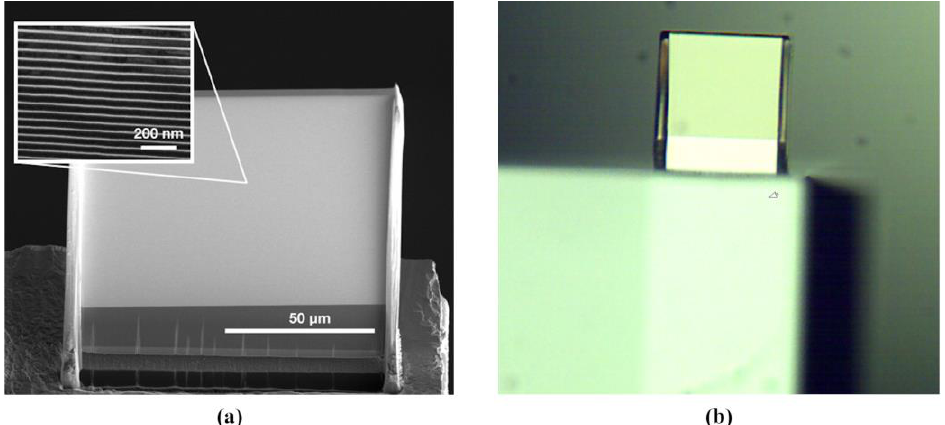
Figure 1. Scanning microscopy image of a 100 μm tall MLL used in the XFEL experiment. The MLL consists of individual nanometer-thick layers shown in the insert, visualized with a high-resolution transmission electron microscope ( a ). The same MLL was imaged with an optical microscope ( b ). The MLL is positioned above the substrate and adhered in two positions (left and right) to the diamond substrate using Pt.